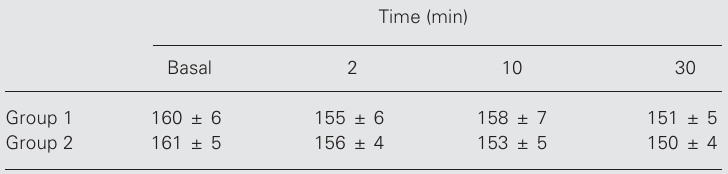
Table 2. Chronotropic response to L-NAME by isolated atria.